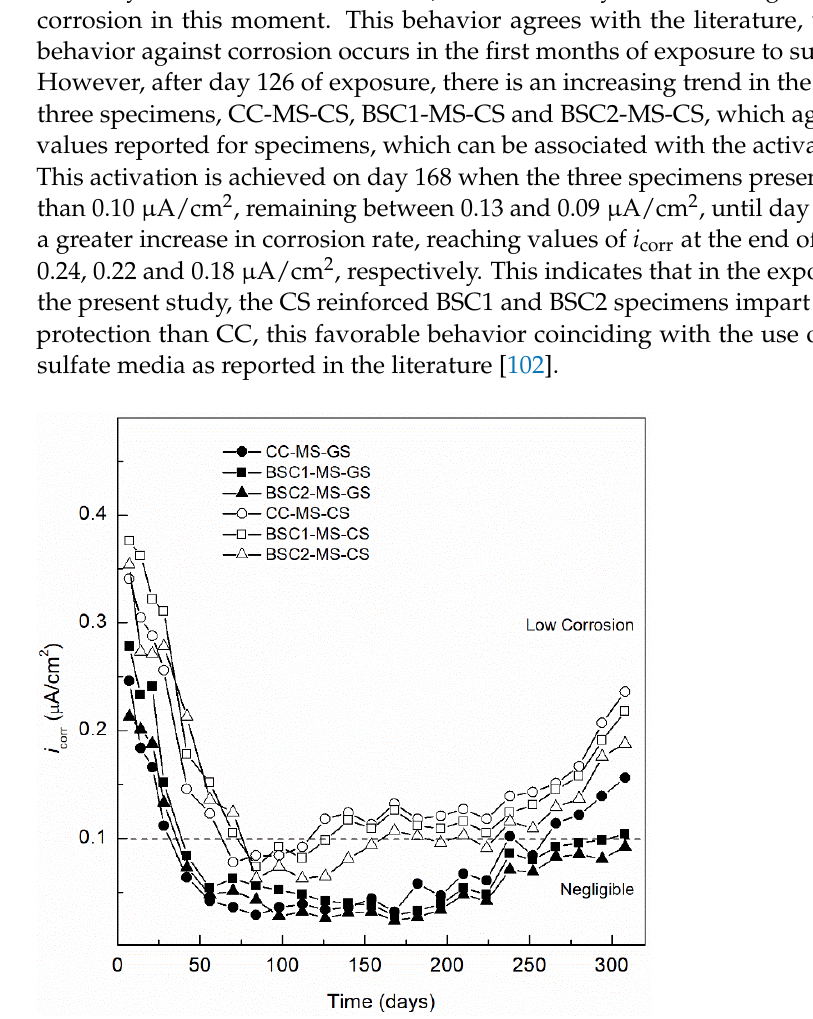
Figure 7. i corr monitoring of GS and CS reinforced concrete exposed to 3.5 wt.% MgSO 4